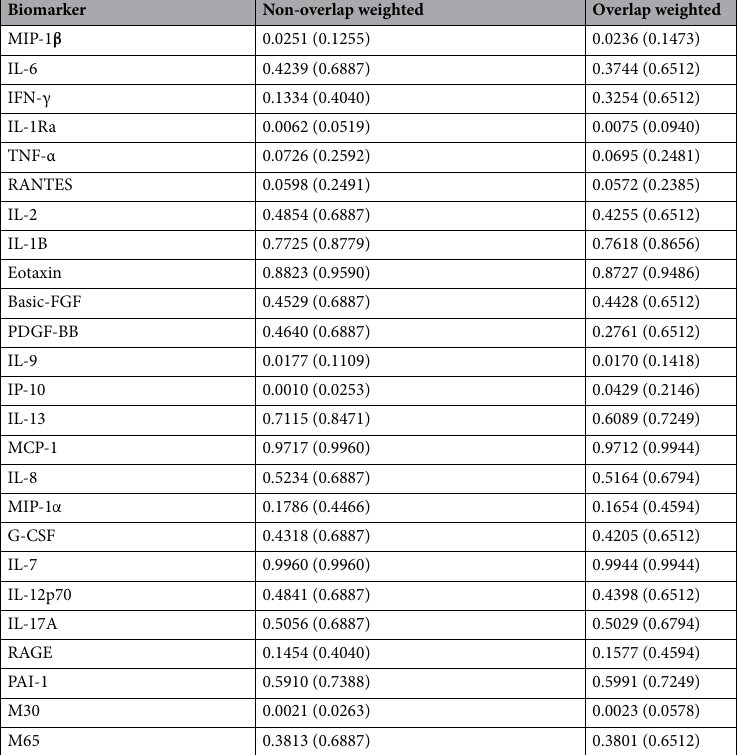
Table 2. Biomarker evolution over 72-h post-lung transplant between patients with and without PGD3 at T48–72 h. Because time and cytokine level are not linearly associated, B-spline basis on time, f B ( time ) , was used to induce nonlinear structure. Moreover, f B ( time ) , PGD3, and f B ( time ) × PGD3 were used as fixed effects, and random effects were allowed across subjects. f B ( time ) × PGD3 captures whether cytokines are differently expressed due to time and PGD status. The LMMs were fitted on log scale when there were no missing data to reduce residual errors. Overlap weighting was also used to adjust for the following five factors: BMI, hypertension, type of transplant (single versus bilateral), EVLP, and type of intraoperative ECLS. We used overlap weighting here to achieve exact balance in means of any confounders between patients that did or did not develop PGD3 at T48–72 h. p- value less than 0.05 suggests that the biomarker evolution is different between patients that did or did not develop PGD3 at T48–72 h. Values in the parentheses are